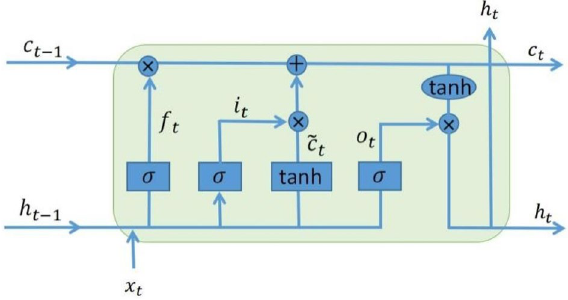
Figure 3. Structure of LSTM neural network model ( f t , i t , and o t are forget gate, input gate and output gate respectively; σ and tanh are activation functions; ⊗ is matrix and element product, ⊕ is